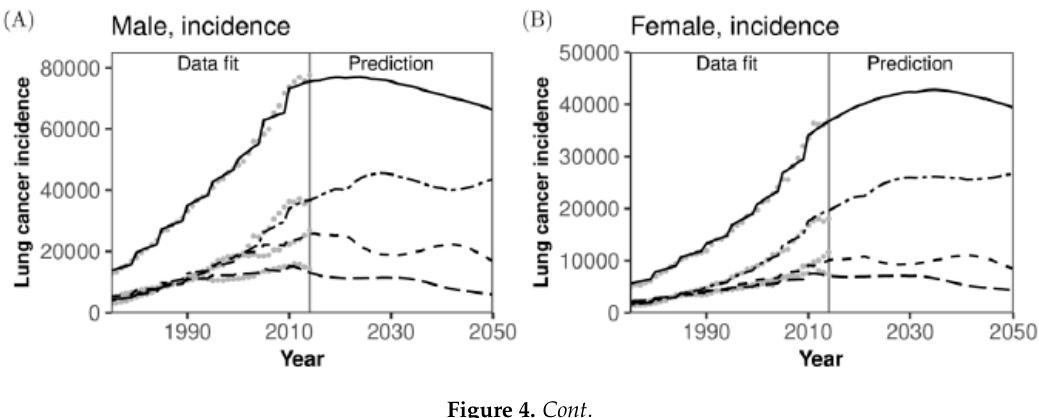
Figure 3. Comparison between observed and predicted lung cancer incidence and mortality per 100,000 population in Japan. Comparisons between observed and predicted lung cancer incidence and mortality per 100,000 population are made by age group and sex. ( A ) Lung cancer incidence in men, ( B ) Lung cancer incidence in women, ( C ) Mortality in men, and ( D ) Mortality in women. Bold dashed line represents working-age population aged 15–64 years, thin dashed line corresponds to those aged 65–74 years, uneven dashed line represents those aged 75 years or older, and solid line represents the entire population. Grey dots before 2014 were used to estimate model fitting parameters via the maximum likelihood method, and lines for 2015 and later are predictions calculated using maximum likelihood estimates at the latest time. The 95% confidence intervals are omitted from predictions because of the narrow uncertainty bounds.